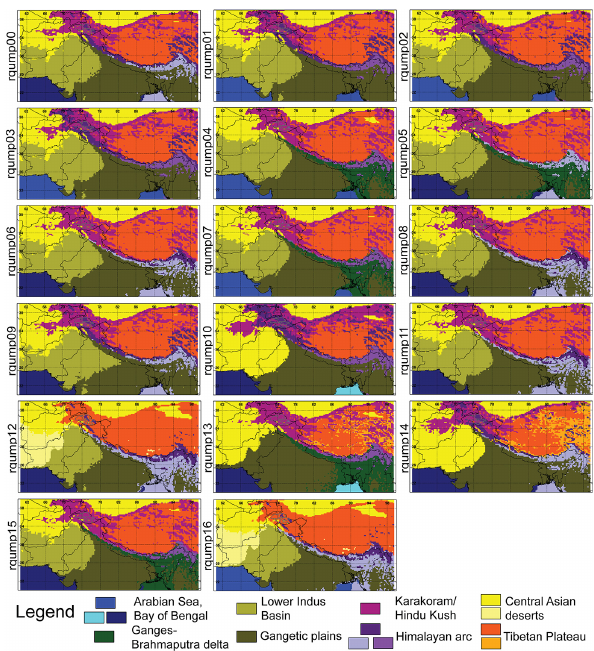
Figure 8. Comparison of climate classifications resulting from the use of eight clusters on principal components of the control period (1970 to 1999) from the individual members of the Hadley Centre RQUMP perturbed physics ensemble downscaled over South